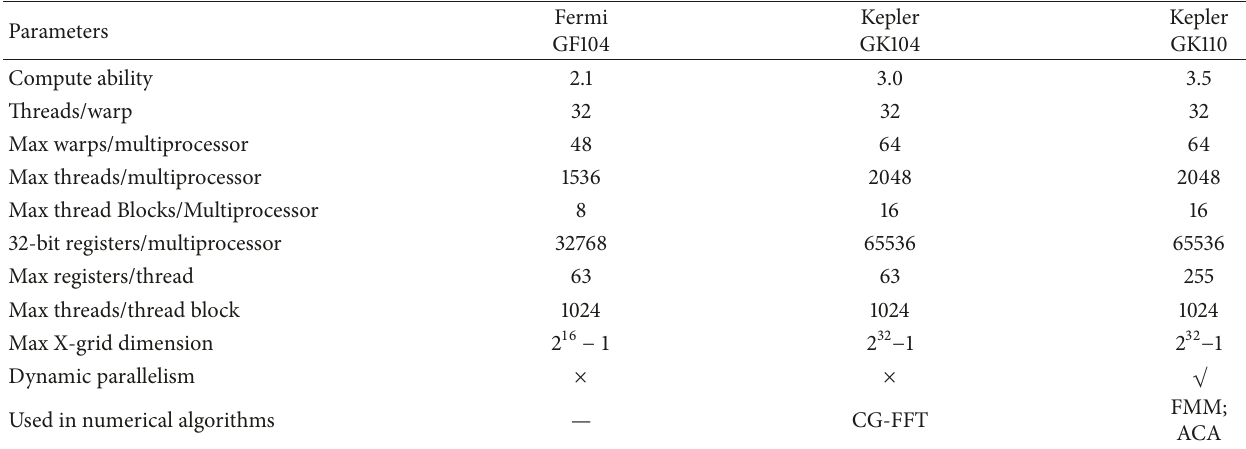
Table 1: Detailed parameters of GPU